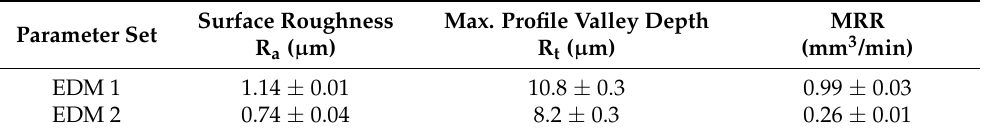
Table 3. Surface roughness R a , maximum Profile valley depth R t and material removal rates MRR of ED-machined 28 WC-1400 for the two studied EDM parameter sets (see Table 2). Parameter